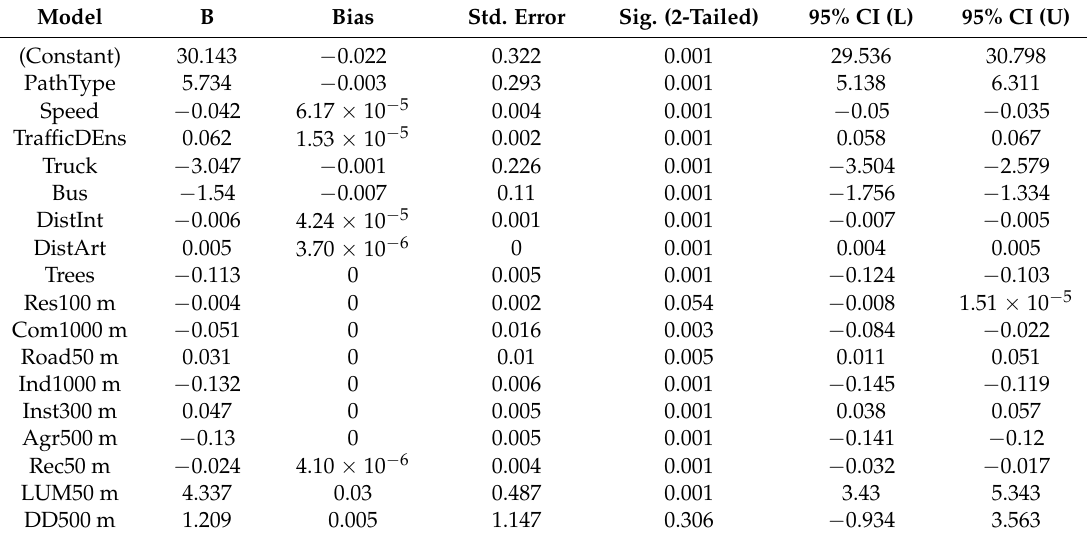
Table A2. Day3: Bootstrap for Coefficients.